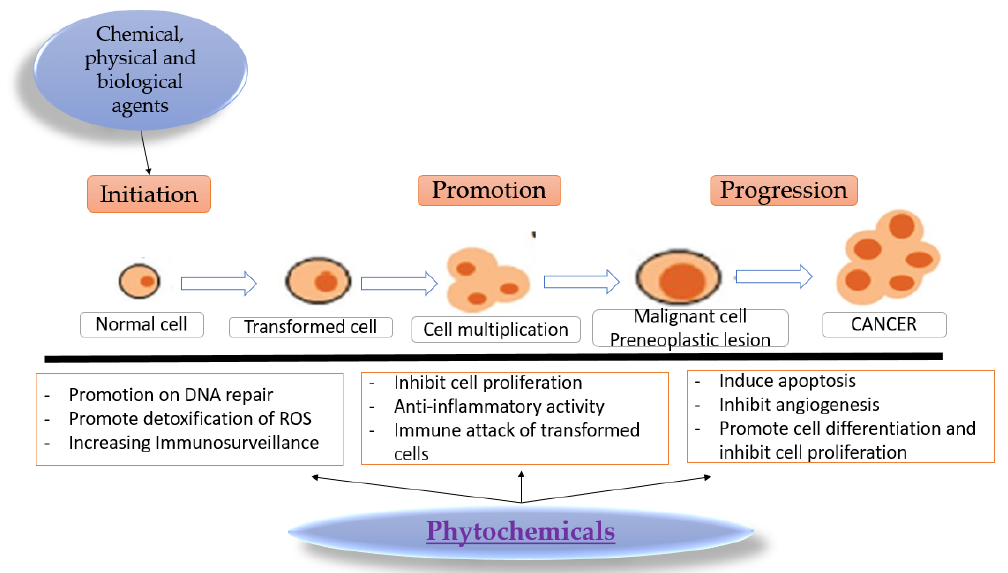
Figure 1. Carcinogenesis mechanism—a multistep process induced by a wide range of chemical, physical, and biological agents and that is interfered with by the protective and anticancer activity of phytochemicals (adapted after Kotecha [36] and Harris [46]).